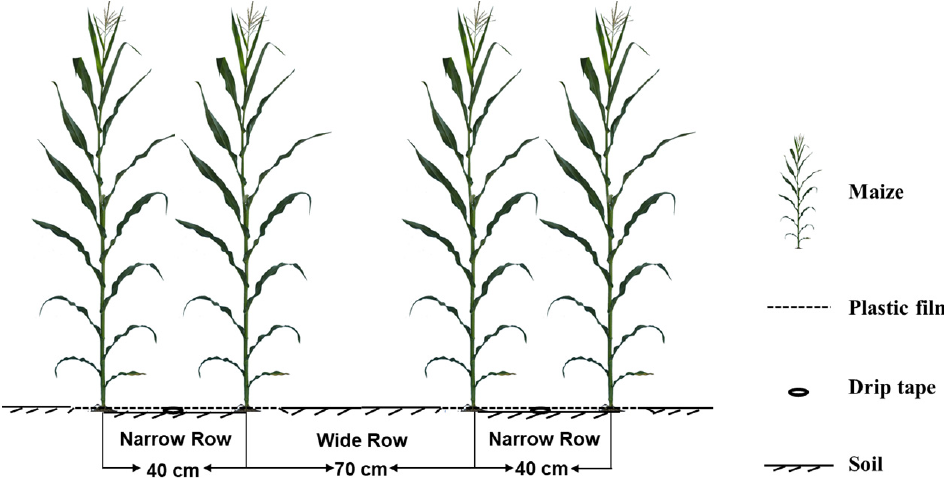
Figure 1. Schematic diagram showing the planting patterns in the experimental field. In the two-year field experiment, fertilizer containing 69 kg N ha − 1 , 99 kg P ha − 1 ,